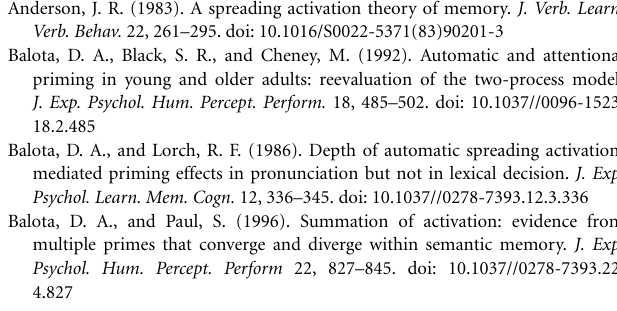
The network parameters for the semantic and lexical net- works that were used in all of the reported simulations can be found in Table 3 . Parameters of the orthographic network used in Section Frequency, Degradation and Context Interactions are given here: the orthographic network contained 500 neurons with in Table 3 ) were: Lexical-to-orthographic: 0.75; orthographic- to-lexical: 0.56/0.543 for high/low frequency. Gain of external visual input was 1.5. The Input time-delay was controlled by a time constant, τ ext , which received values of 0.66 ms/134 ms for clear/degraded